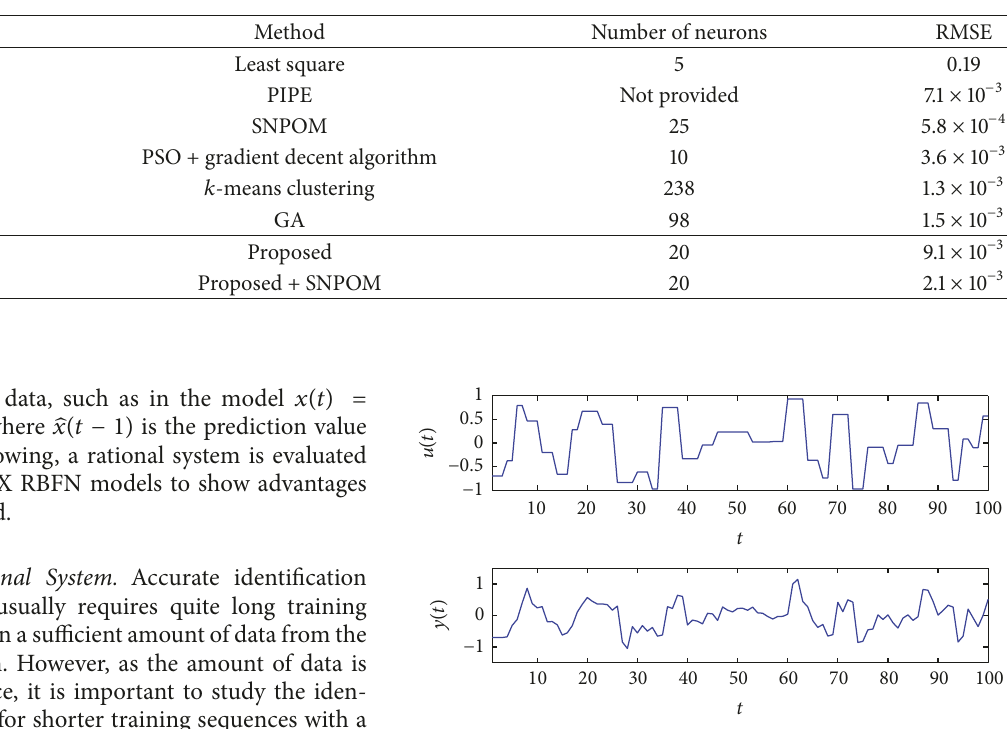
Table 1: Results of different models for Mackey-Glass time series prediction.